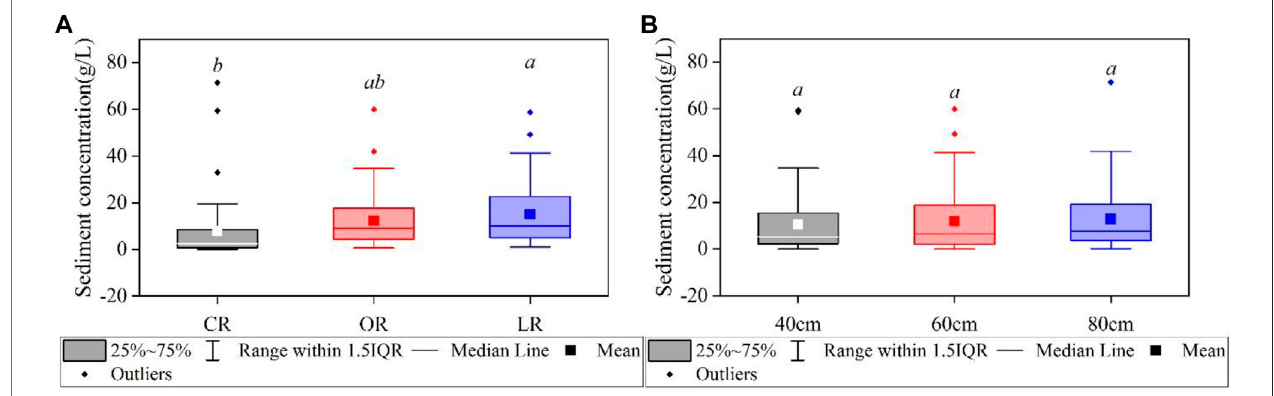
FIGURE 5 | Runoff sediment concentration under different ridge directions (A) and ridge widths (B) , and boxes labeled with different letters indicate signi fi cant differencesat p < 0.05.CR,OR,andLRrepresentcross-ridgetillage,oblique-ridgetillage,andlongitudinal-ridgetillage,respectively.40,60,and80 cmrepresent40 cm ridge width, 60 cm ridge width, and 80 cm ridge width, respectively.